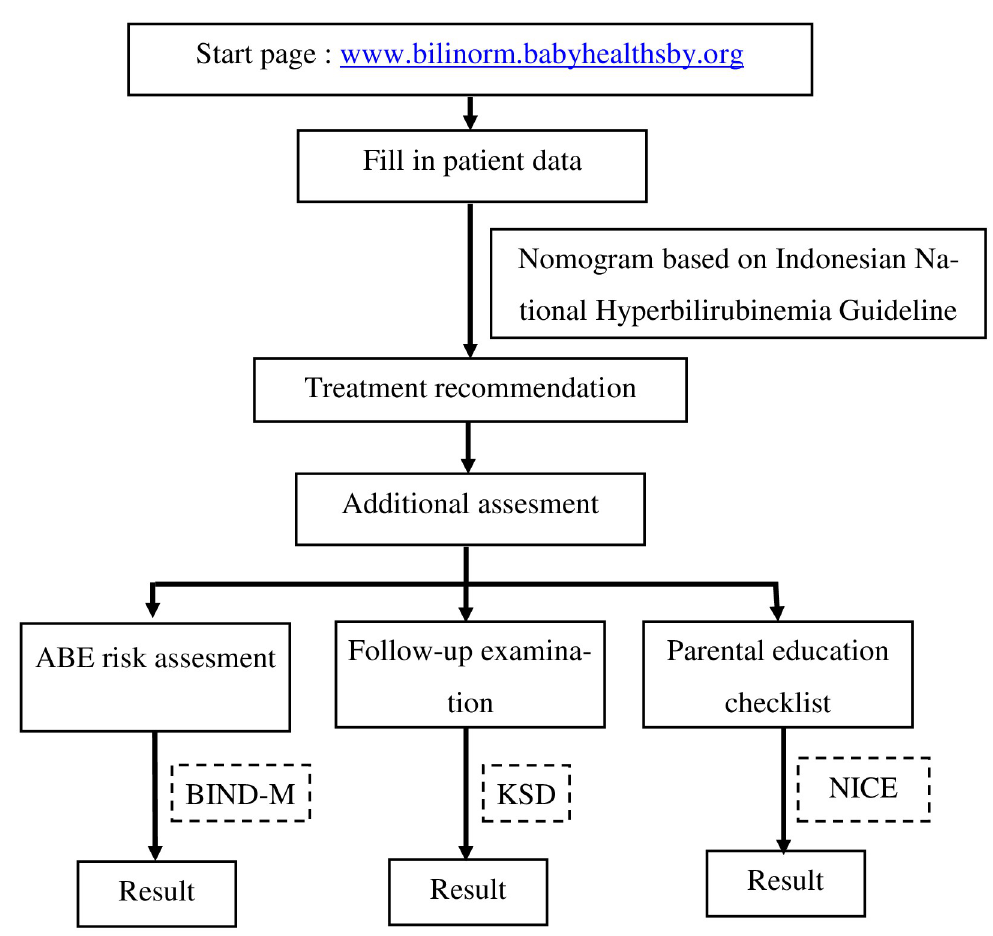
Fig 3. Research algorithm. Fig 3 shows the proportion of infants < 35 weeks of gestational age and 35 weeks of gestational age categorised according to treatment classification. According to the results, BiliNorm showed a good contribution, especially for infants < 35 weeks of gestational age. This can be observed by the increased rate of correct treatment and a reduction of inappropriate treatment in BiliNorm. Abbreviation (ABE = Acute Bilirubin Encephalopathy, BIND-M = Bilirubin Induced Neurological Dysfunction-Modified, KSD = Kernicterus Spectrum Disorder, NICE = National Institute for Health and Care